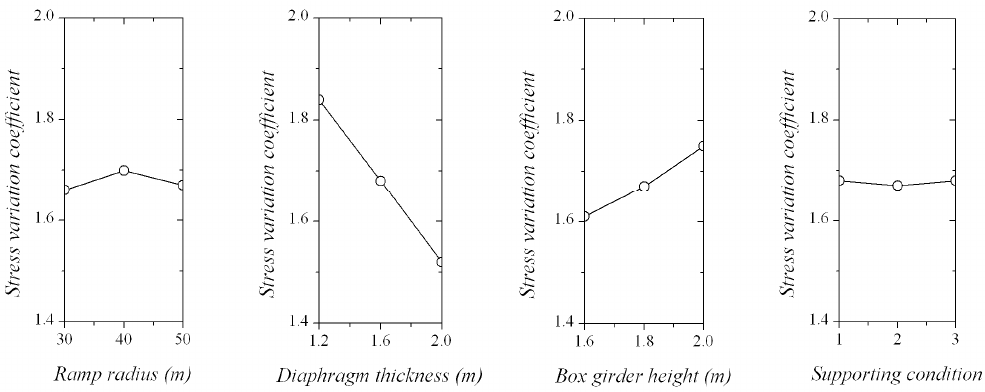
Figure 8. Influence of varying parameters on the stress variation coefficient.